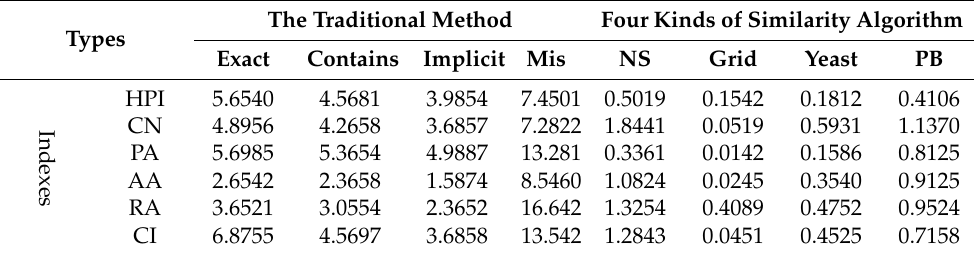
Figure 9. The visualization of the NS network. Table 6. The operating time (s) of the traditional method and 4 kinds of similarity algorithms based on a complex network.